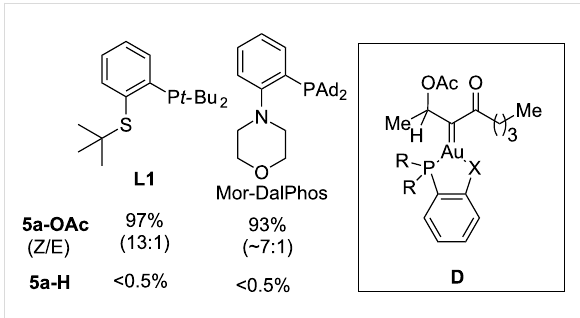
Figure 1: The impact of ligands on the ratio of 5a-OAc and 5a-H in the gold-catalyzed oxidation of 4a (reaction conditions: 5 mol % gold cata- lyst, 1.5 equiv of 3 , DCE, rt, 3